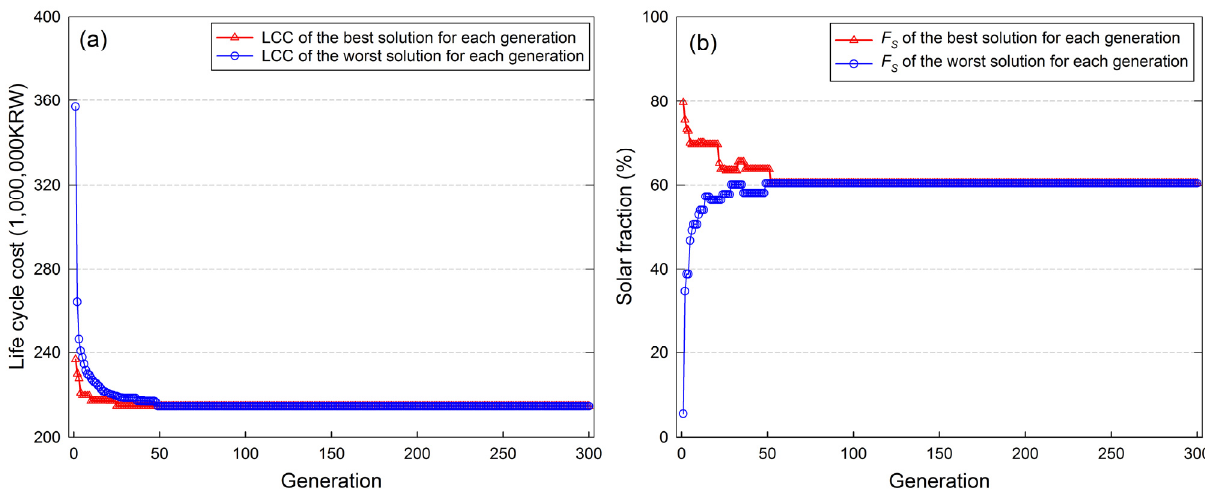
Figure 4. Evolution of ( a ) the objective function and ( b ) the solar fraction during the optimization process for the base